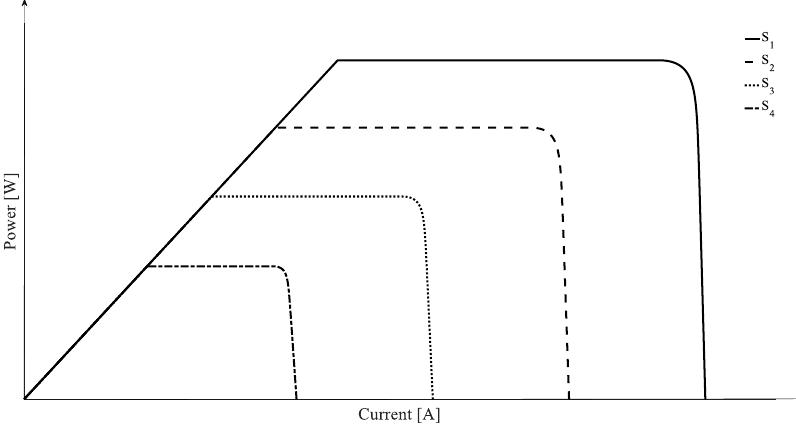
Figure 4. Power versus current (P-I) characteristic of boost-based SCPVM.